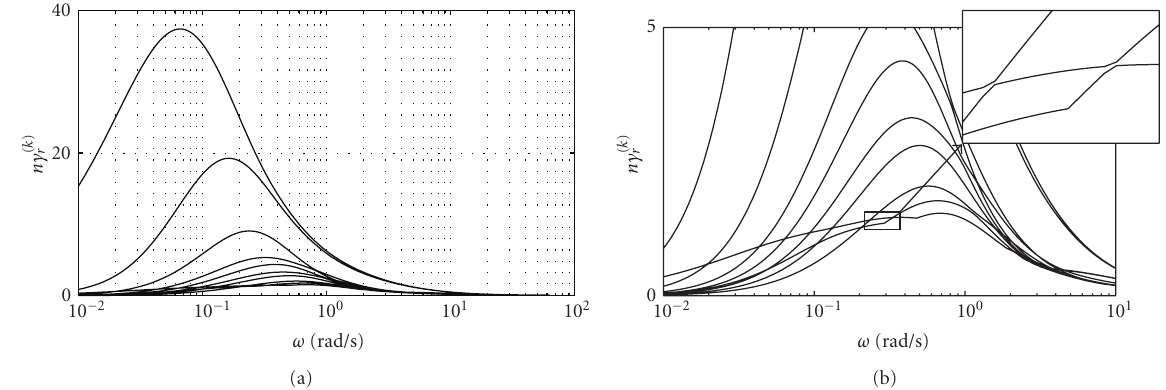
Figure 15: Example 2: first ten nondimensional eigenvalues (POD) of atmospheric turbulence as a function of the circular frequency ω (a); detailed view (b).